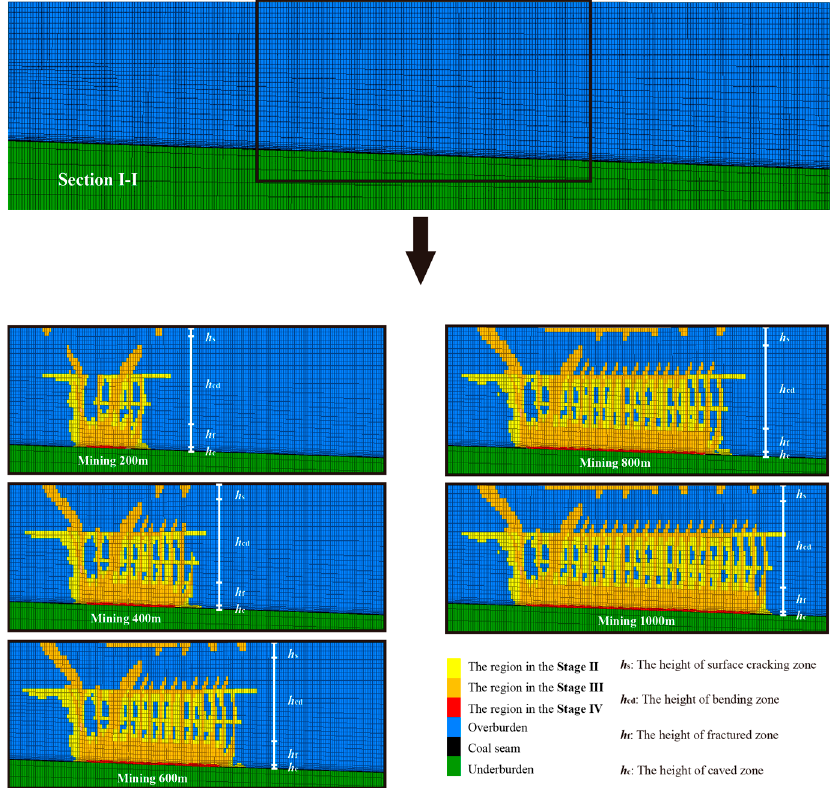
Figure 15. Evolution laws of the four zones due to excavation (200 m, 400 m, 600 m, 800 m, and 1000 m).